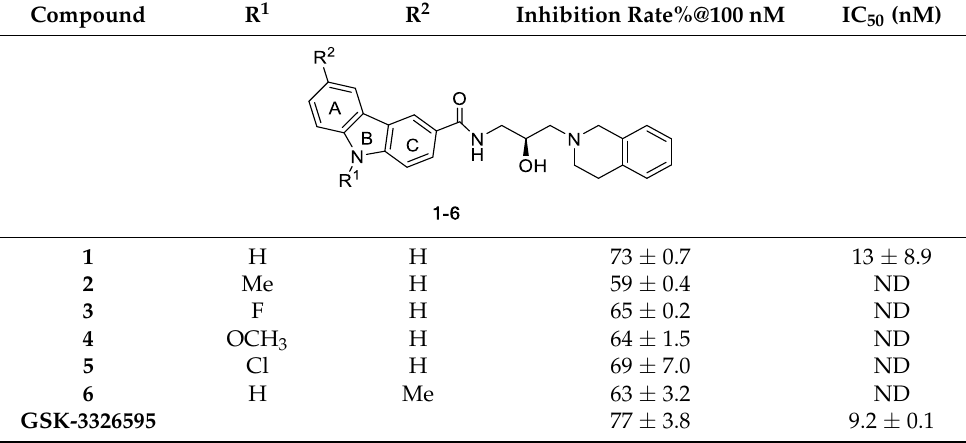
Table 1. In Vitro PRMT5 Inhibitory activity of compounds 1 ~ 6 .